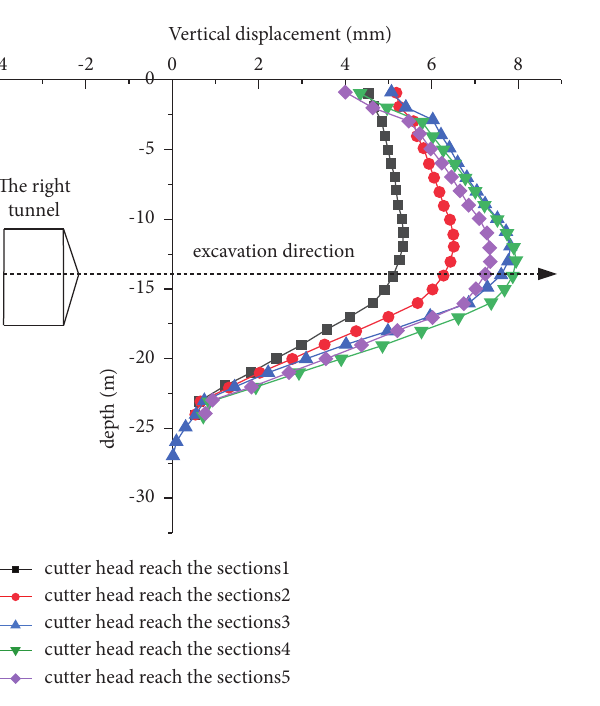
Figure 25: The right tunnel excavation gap filling.